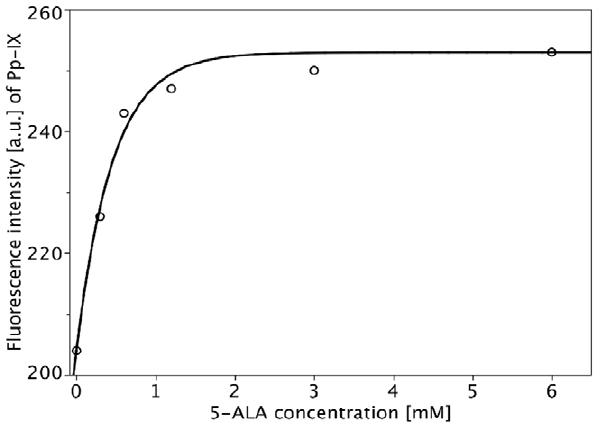
Figure 1. Concentration-dependent 5-ALA induction of PpIX. Each symbol represents the mean value of 60 measurements (20 individual cells/3 independent experiments) determined by fluores- cence microscopy. The mathematical model used to calculate the fitted curves is given by Formula (1). The parameters are: b ~ 204 a : u :